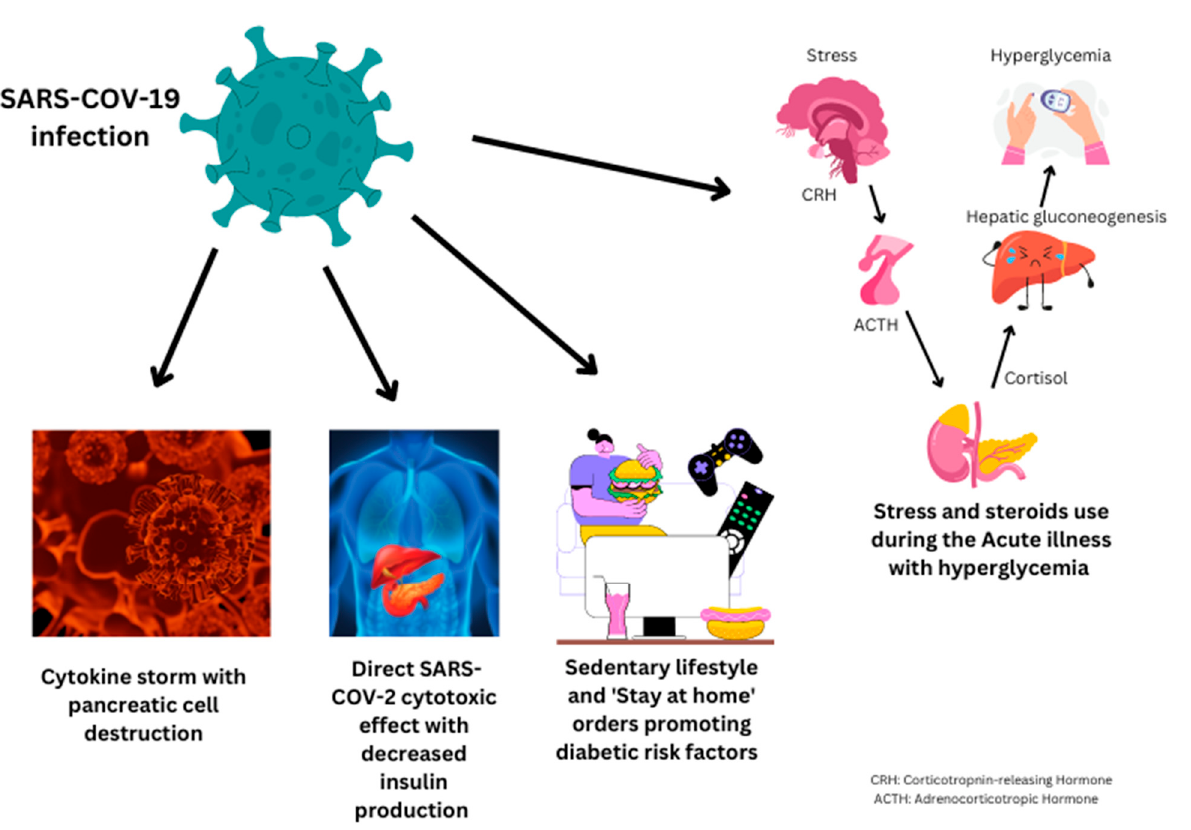
Figure 1. Possible mechanisms for COVID-19 infection and new-onset diabetes mellitus.